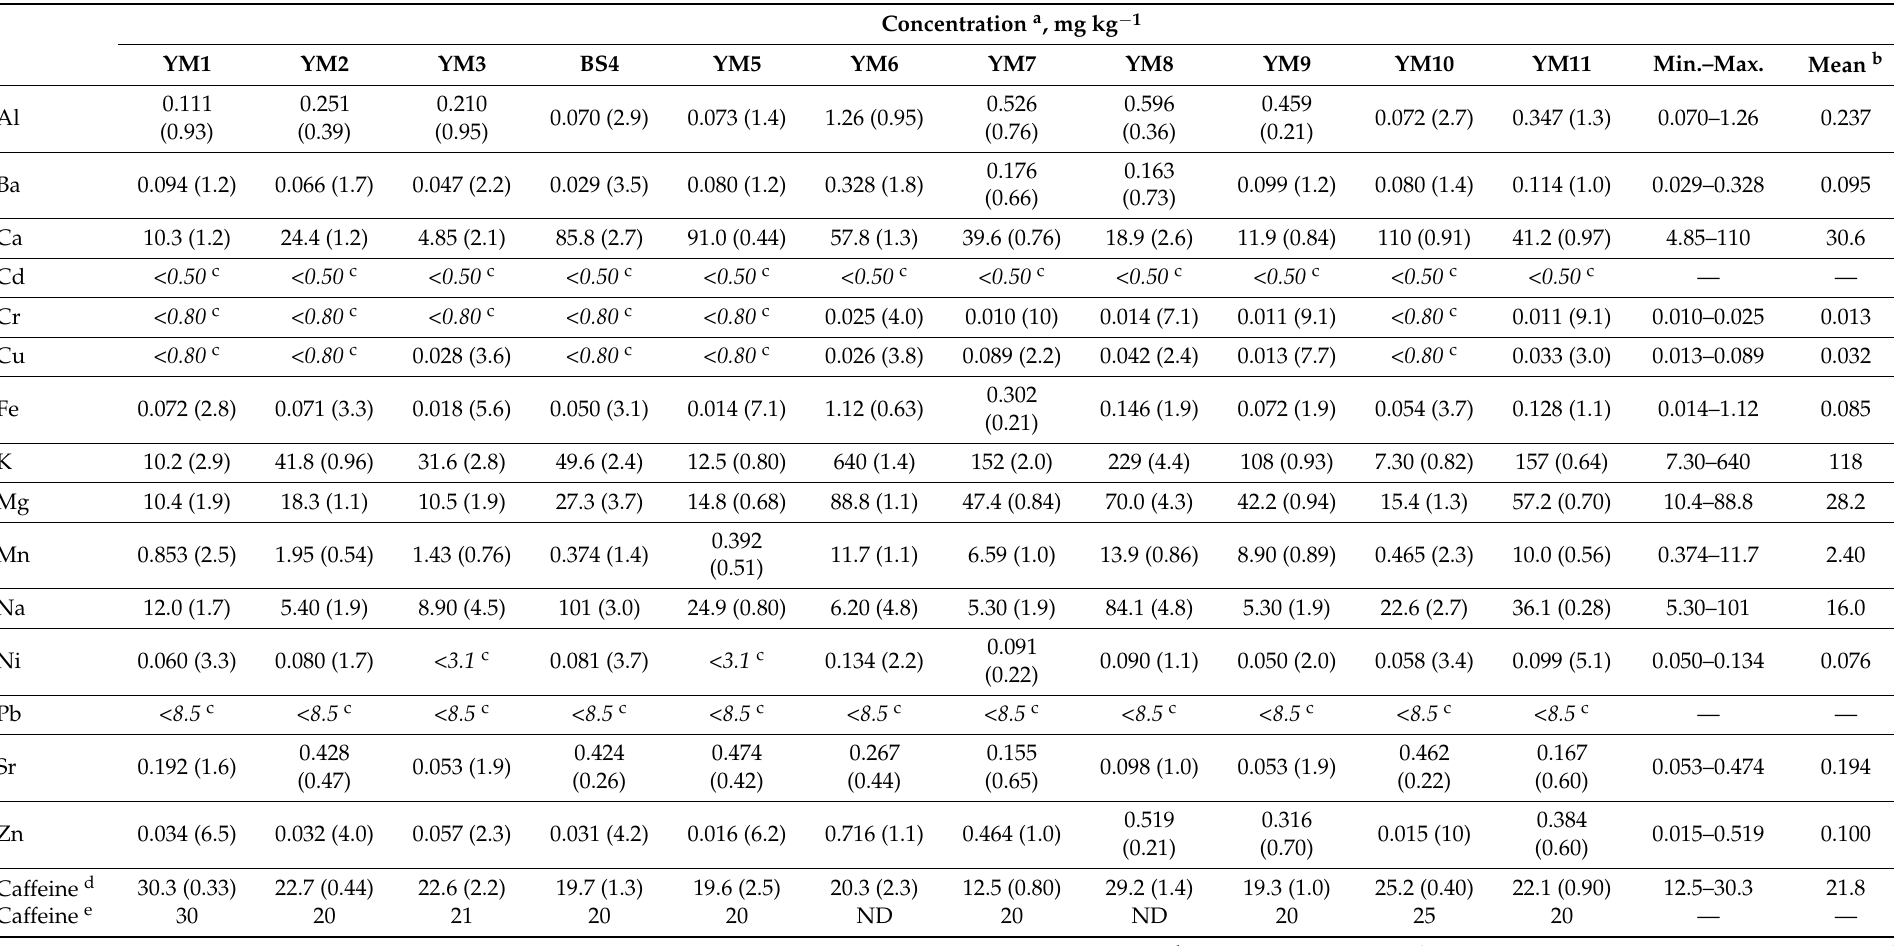
ND: not declared. a Average values ( n = 3) with relative standard deviations (%RSDs) in brackets. b Geometric mean (mg kg − 1 ). c Below the method detection limit (MLOD, ng g − 1 ). d Average values ( n = 3) in mg/100 mL with relative standard deviations (%RSDs) in brackets. e Caffeine content declared by the producer (in mg/100